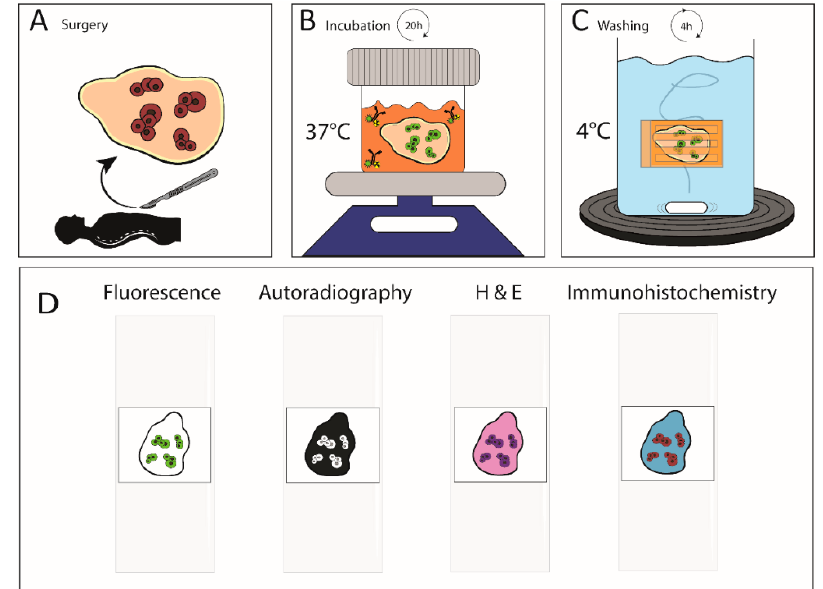
Figure 3. Method of ex vivo incubation of surgical tissue samples with 111 In-DOTA-hMN-14-IRDye800CW. ( A ) surgical resection of tumor specimen and tissue preparation. ( B ) Overnight incubation with 111 In-DOTA-hMN-14-IRDye800CW at 37 °C on orbital shaker with antibiotic additives. ( C ) Four hours washing of unbound antibody-conjugate at 4 °C. ( D ) Formalin-fixation, paraffin embedding and mounting of serial slices on glass slides for (immuno)histochemical analyses.